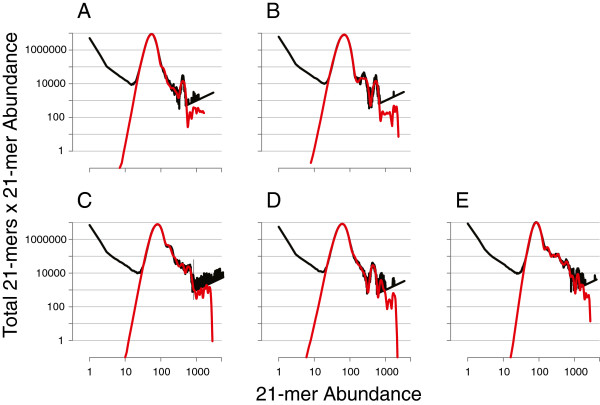
Abundance histograms of icosihenamers (21-mers) for five strains (A–E) of E. coli. Black lines represent the total number of distinct 21-mers at each abundance value (as present in the Illumina short-read dataset for a strain), and red lines are the best-fit model for each of the empirical 21-mer spectra. To increase the area within the plot containing peaks, total numbers of distinct 21-mers are multiplied by their corresponding 21-mer abundances. This transformation does not affect the model fitting, and estimates of repeat structure and genome size remain unaffected. Panel labels are as follows, A: strain A_03_34; B: strain B_04_28; C: strain C_04_22; D: strain D_04_27, E: strain E_01_37.